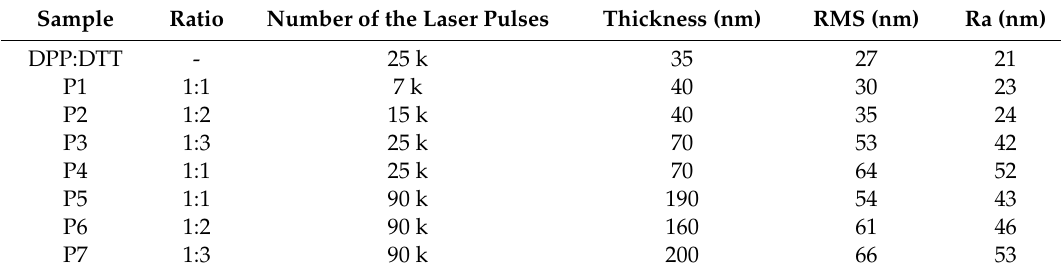
Table 1. Experimental parameters involved in the MAPLE deposition of the organic thin films and their